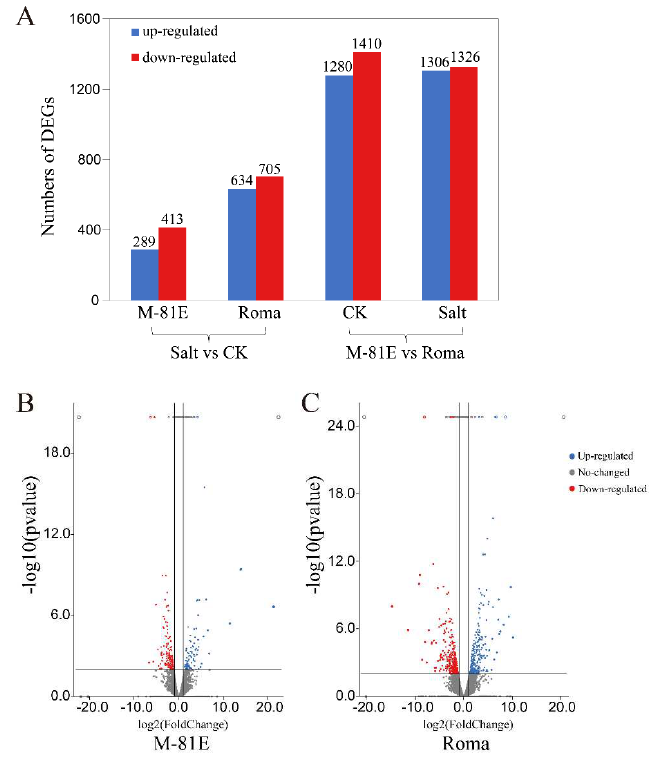
Figure 2. Numbers of differentially expression genes (DEGs) of different genotypes when affected by salt stress. ( A ) DEG distribution of the two treatment groups under normal soil or salt stress conditions; ( B ) volcano plot showing DEGs for M-81E+salt and M-81E; ( C ) volcano plot showing DEGs for Roma+salt and Roma.